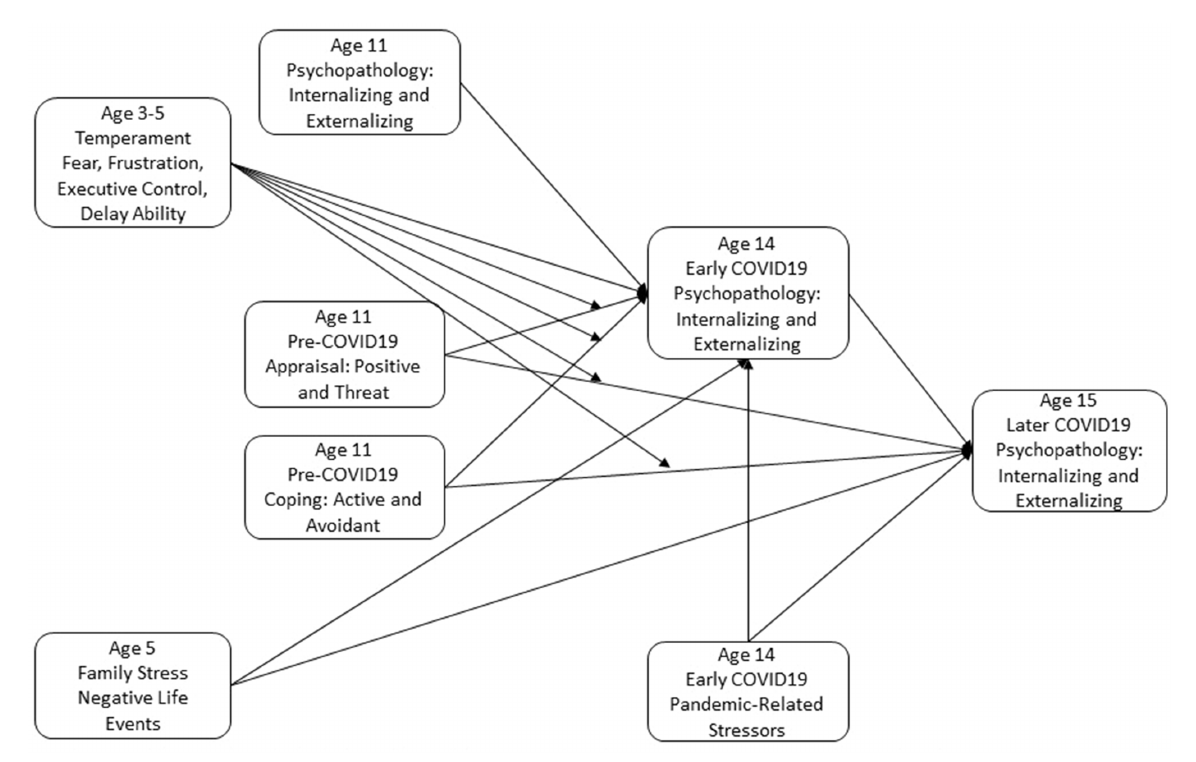
FIGURE 1 Conceptual model of early childhood temperament moderating the associations of appraisal and coping styles with levels of and changes in psychopathology in response to the context of stress posed by the COVID19